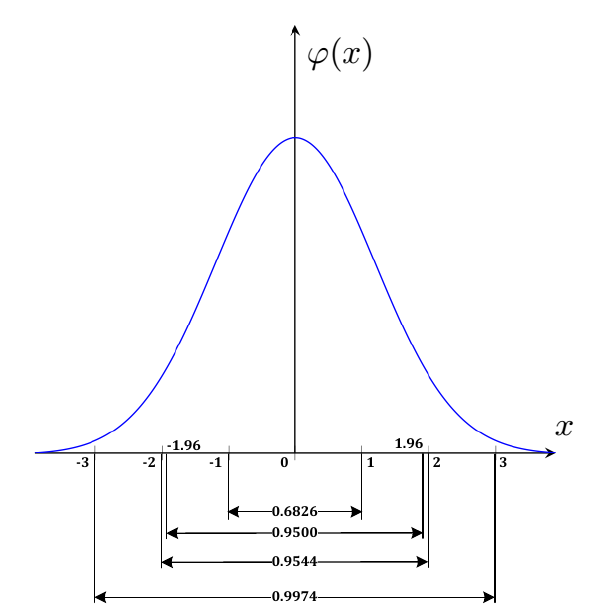
Figure 1. Normal Distribution Probability Plot.